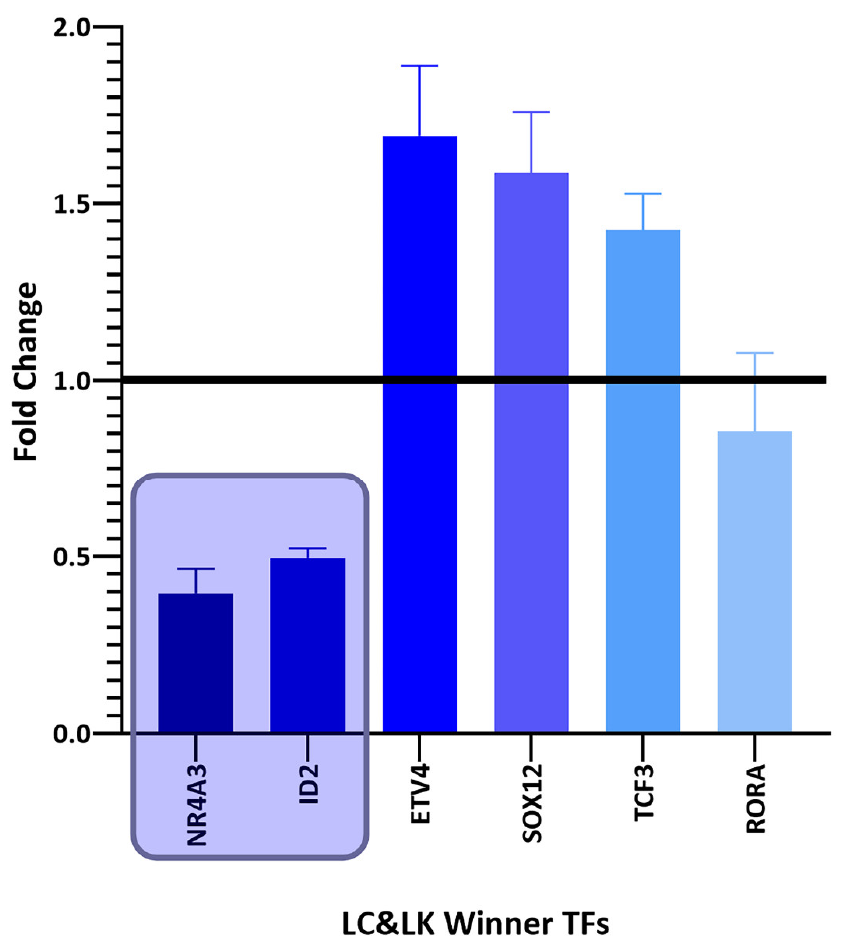
Figure 4. Bar graph comparing the fold change expression levels of common winning transcription factors in lung cancer and leukemia (LC&LK). Transcription factors with fold change values greater than 1 are upregulated, while those with fold change values less than 1 are downregulated. Inside the boxes are the deregulated transcription factors in most datasets and those that are coexpressed in gene networks. The image was made using GraphPad Prism version 8.00 for Windows, GraphPad Software, La Jolla, California, USA, www.graphpad.com (accessed on 23 June 2022) .